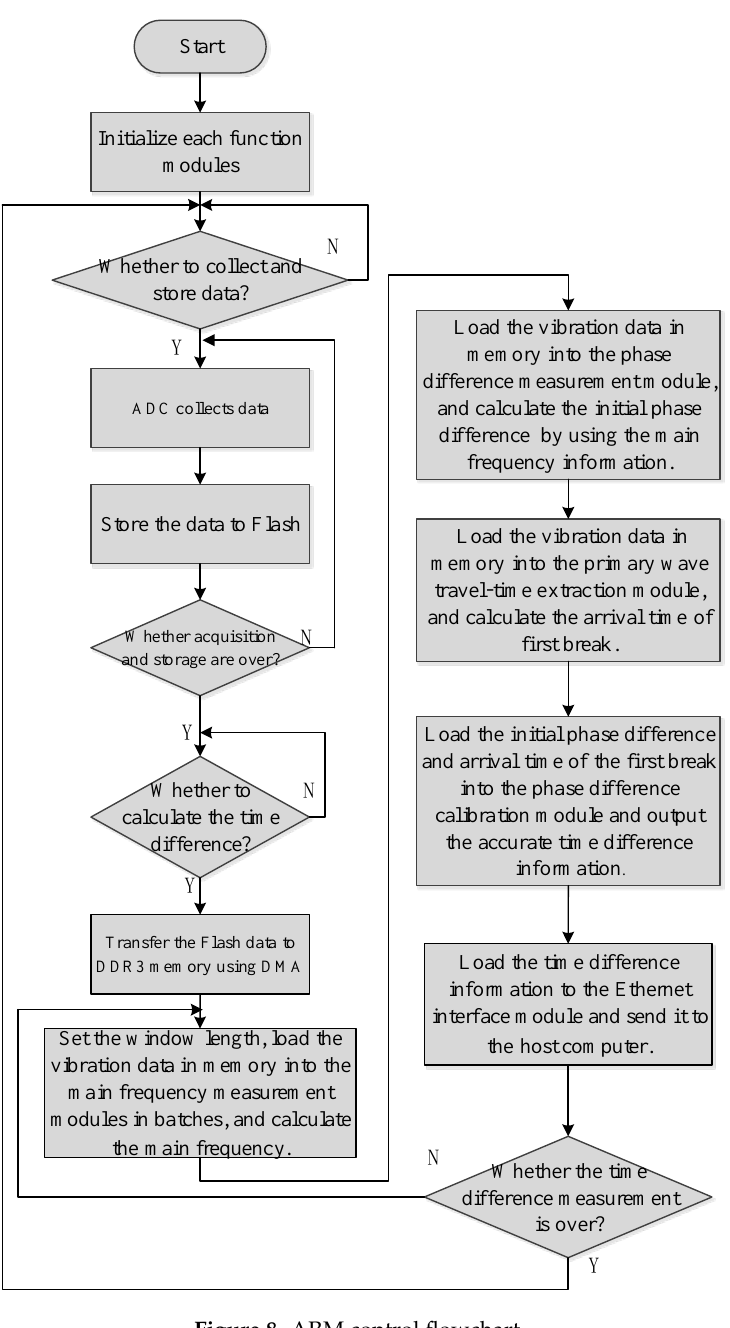
Figure 8. ARM control flowchart.